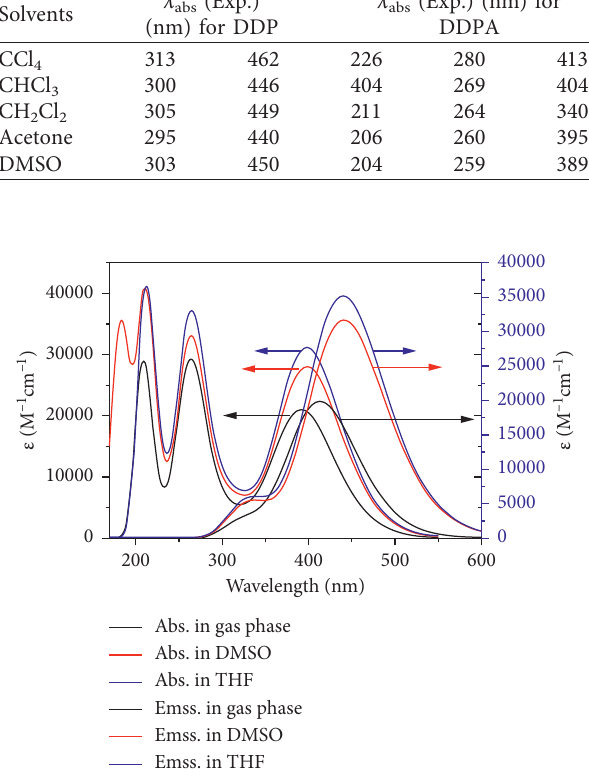
Figure 4: Calculated electronic absorption and emission spectra for the DDP molecule in the gaseous phase (in black), DMSO (in red), and THF (in blue). CAM-B3LYP/6-311G++ (d, p) was